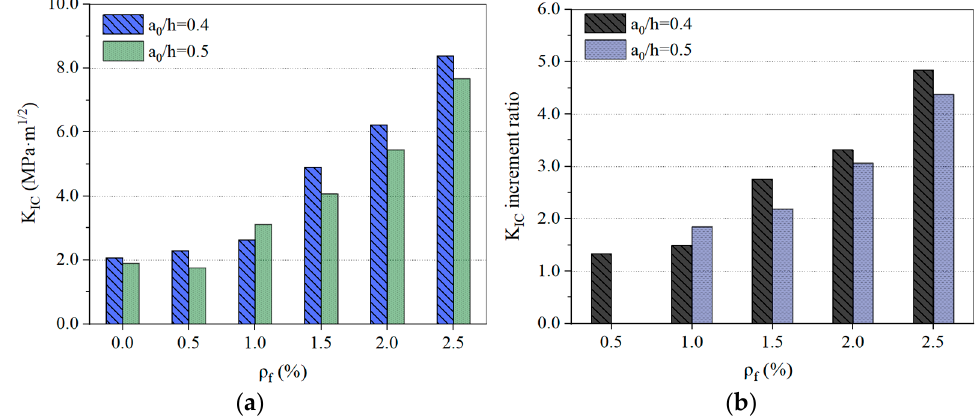
Figure 6. Influence of ρ f on the K IC ( a ) and K IC increment ratio ( b ) of SFHSC.